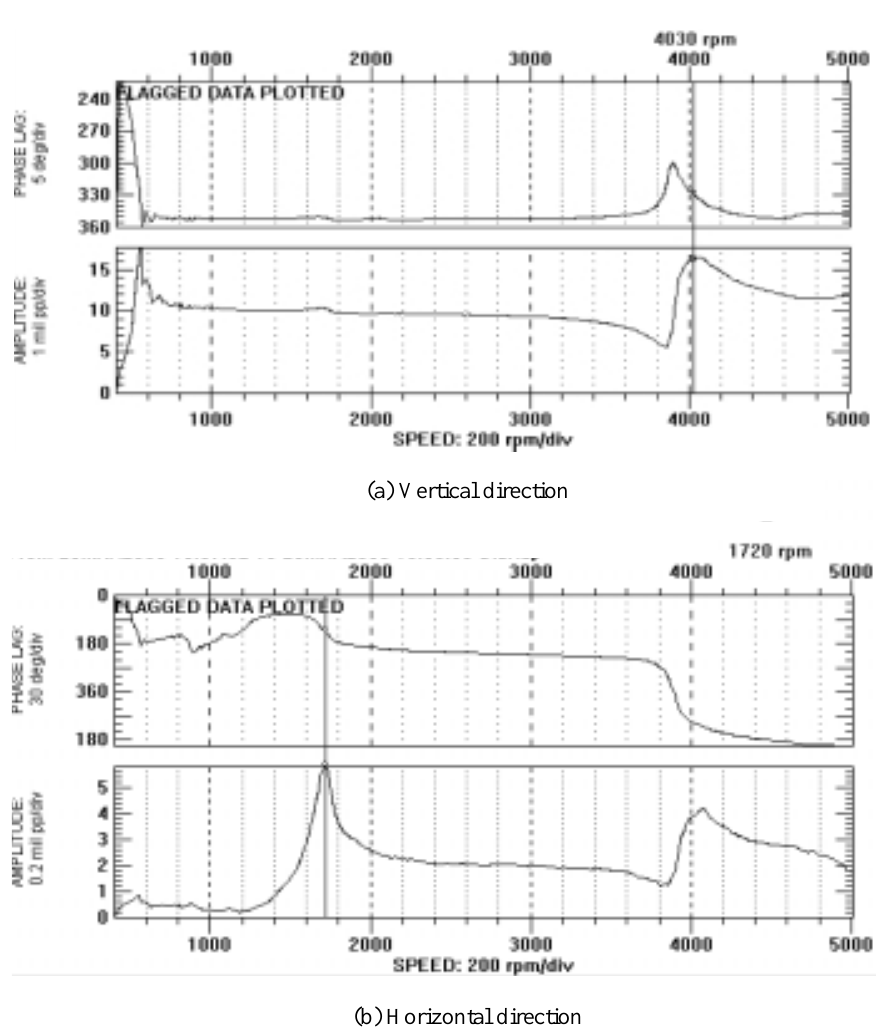
Fig. 6. Bode plots of startup data for the 1st shaft with 4 mm notch crack and 8 kg vertical hanging side